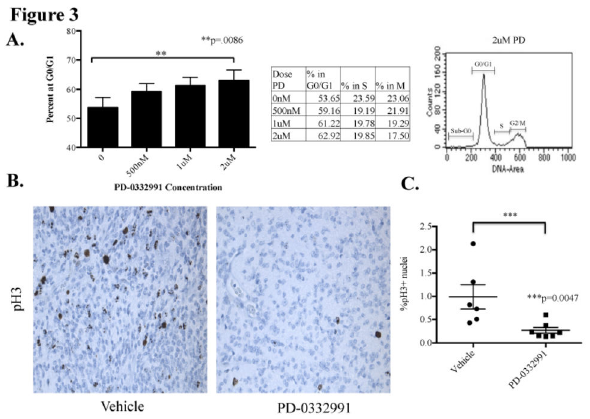
Figure 4. Treatment with PD-0332991 significantly prolongs survival in the Ink4a-ARF deficient BSG